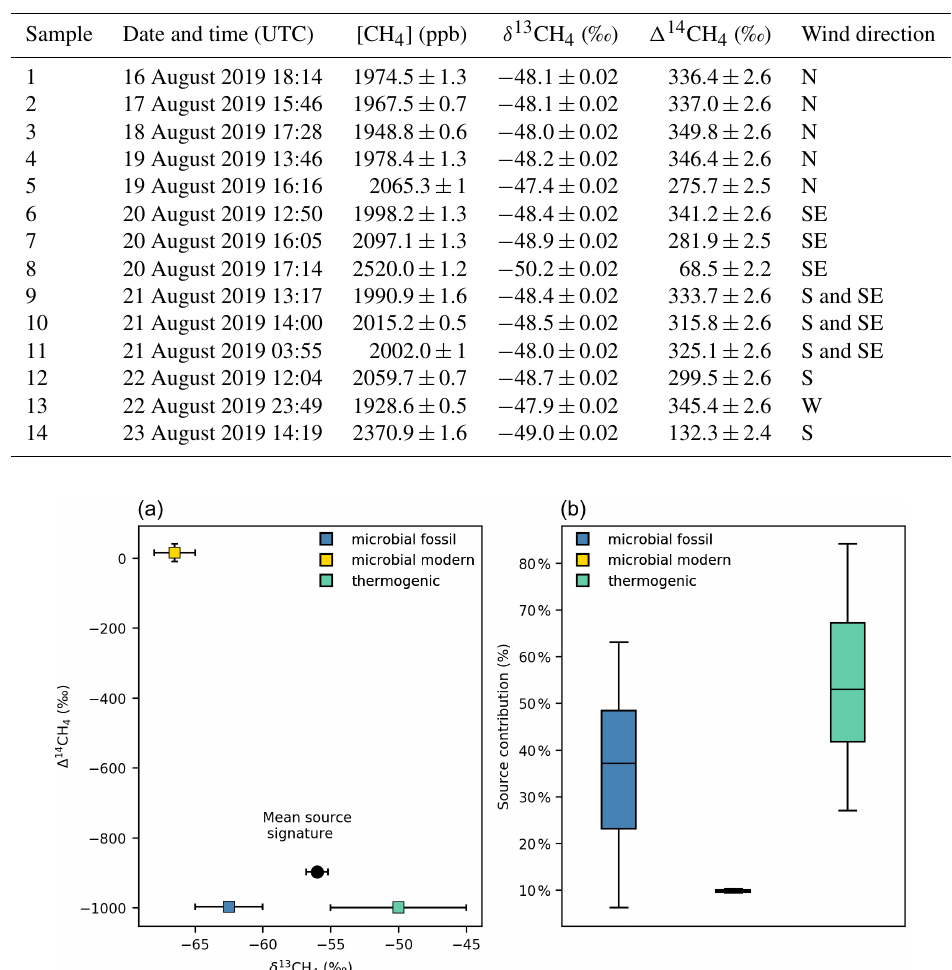
Figure 4. (a) δ 13 C and (cid:49) 14 C signatures of potential CH 4 sources used to estimate source contribution using MixSIAR and mean δ 13 CH 4 and (cid:49) 14 CH 4 source signatures of the samples associated with south trajectories derived from Keeling plots. (b) Boxplot of the estimated source contributions from microbial fossil CH 4 (tailings ponds), thermogenic CH 4 (surface mines and processing facilities), and microbial modern CH 4 (wetlands) for these samples. The line inside the boxes represents the median, boxes indicate the 25th and 75th percentiles, and whiskers show the 5th and 95th